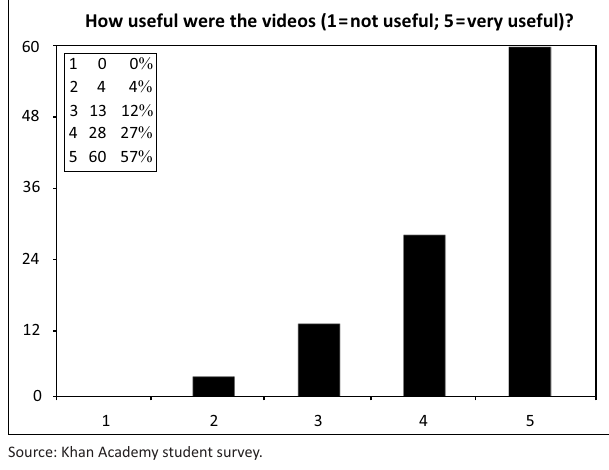
FIGURE 4: Rating on usefulness of videos.